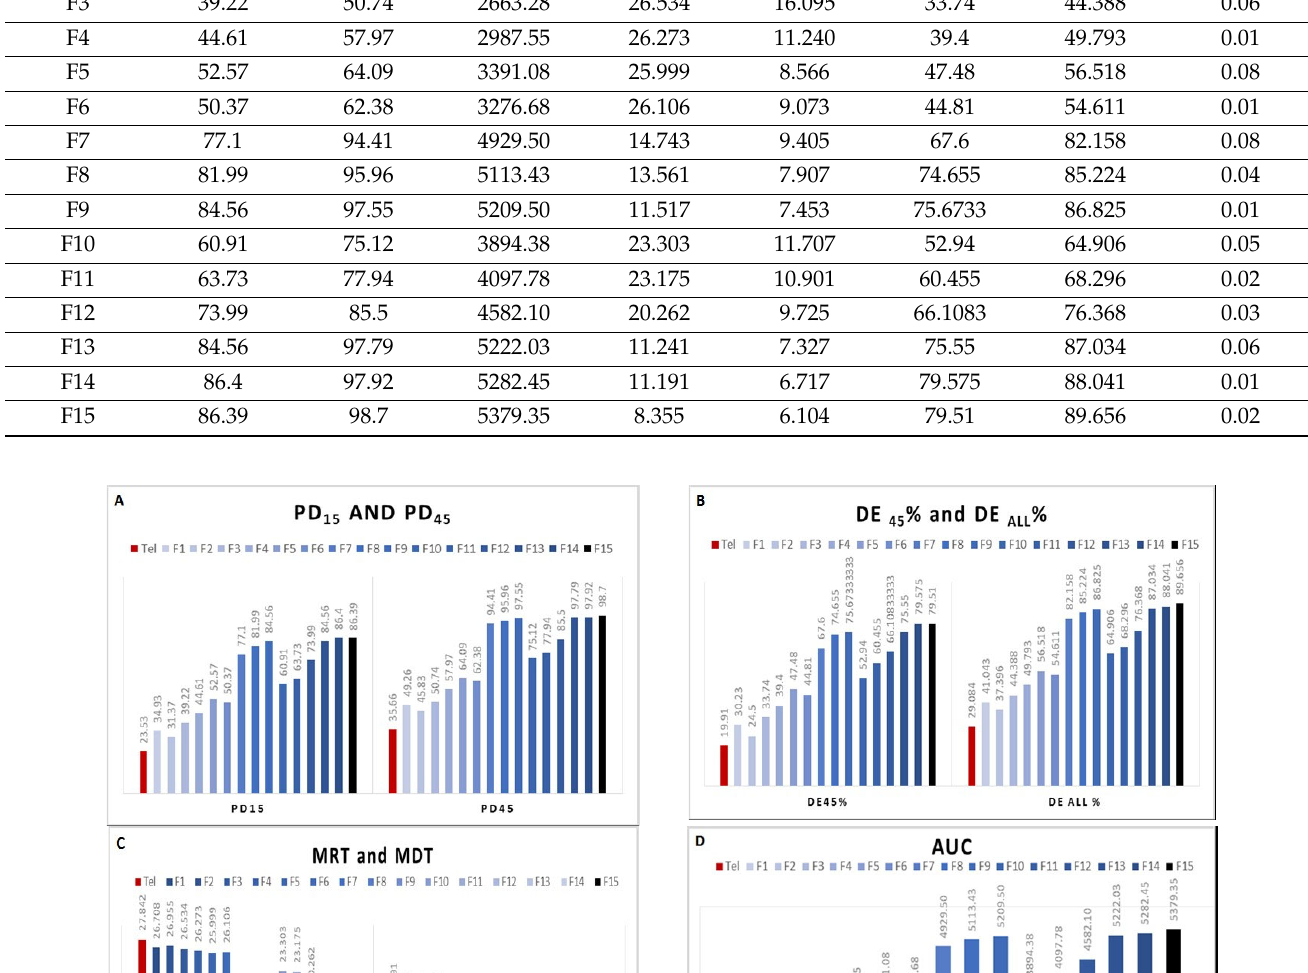
Table 6. Parameters for assessing the similarity and difference between dissolution data of plain Tel versus Tel ‐ SSDs.